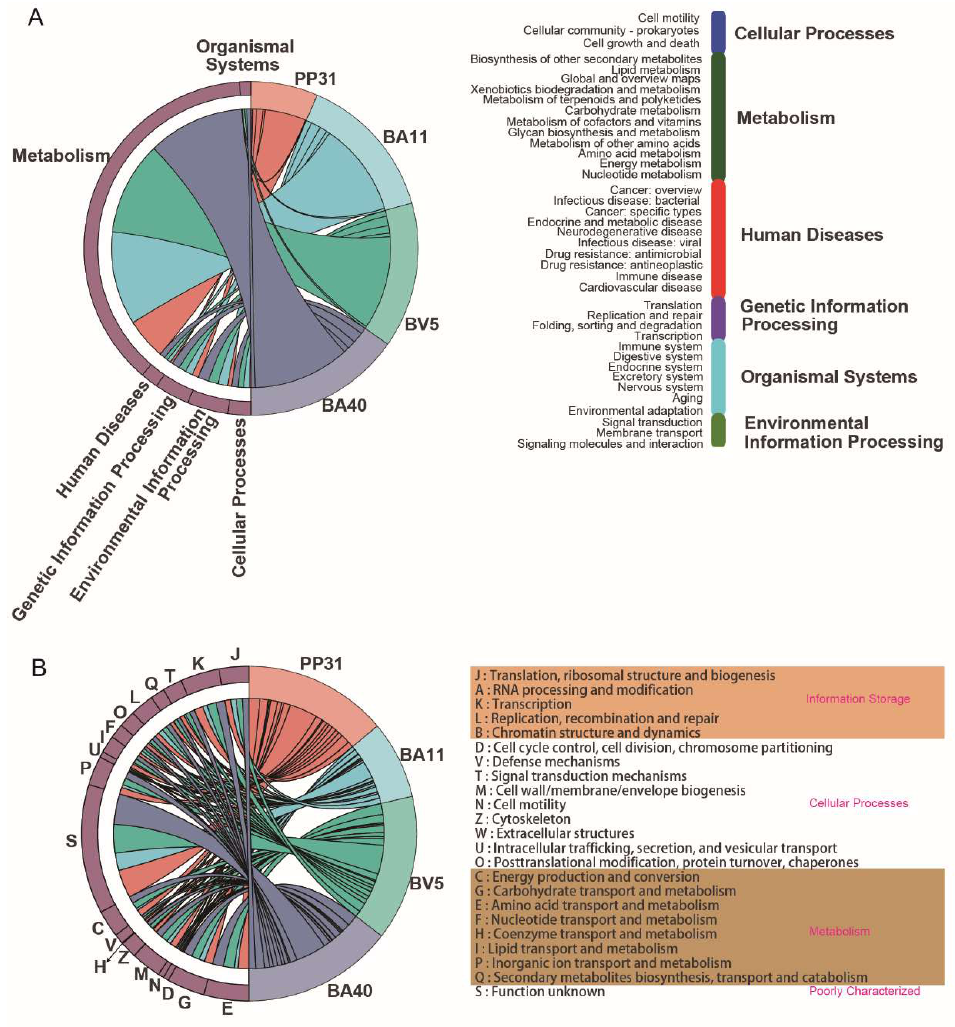
Figure 5. Annotated chord diagrams based on database matching for classification. ( A ) Correspond- ence between annotated information on bacterial genomes and metabolic pathways obtained by KEGG database. ( B ) The COG database was compared to classify the predicted proteins into gene families and to give the corresponding functional annotation information for the family.